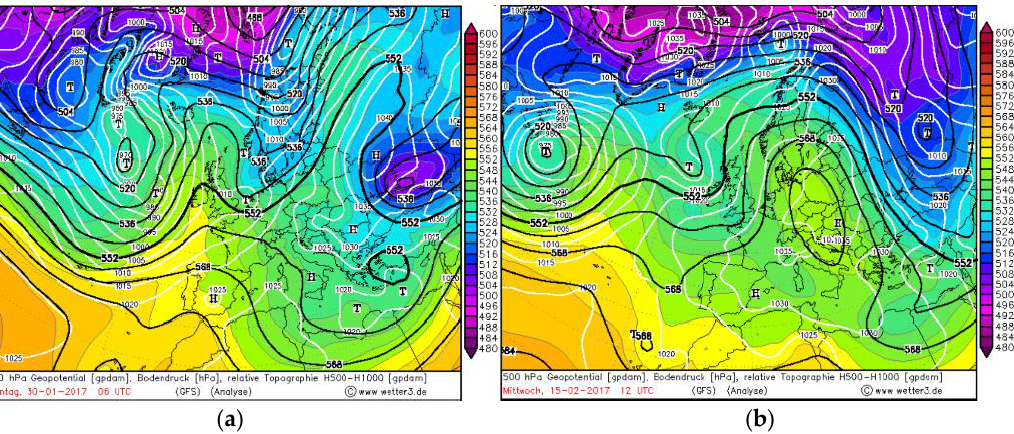
Figure 9. Weather maps for 30 January ( a ) and 15 February ( b ) 2017. The maps show the 500 hPa geopotential (black contours), sea-level pressure (white contours) and relative topography H500–H1000 (color scale) [15].